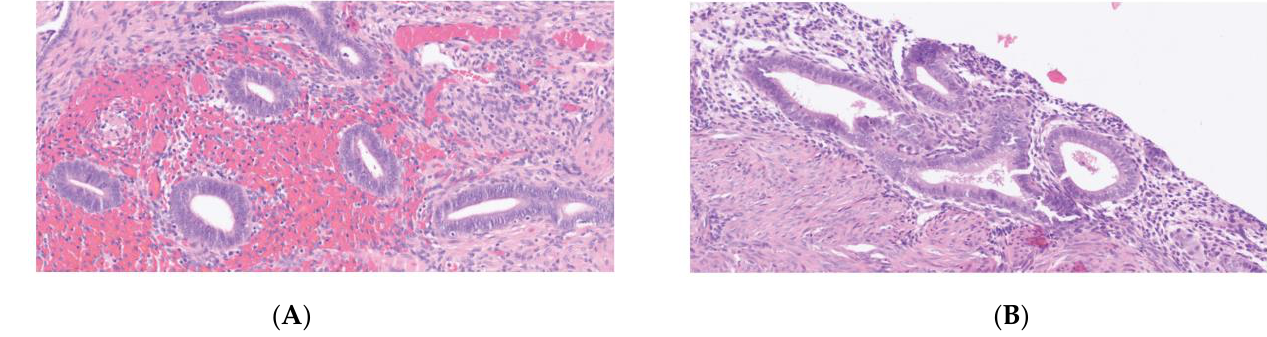
Figure 1. Hematoxylin and eosin (H&E) staining (×200). ( A ) endometriosis. ( B ) uterus remnant.